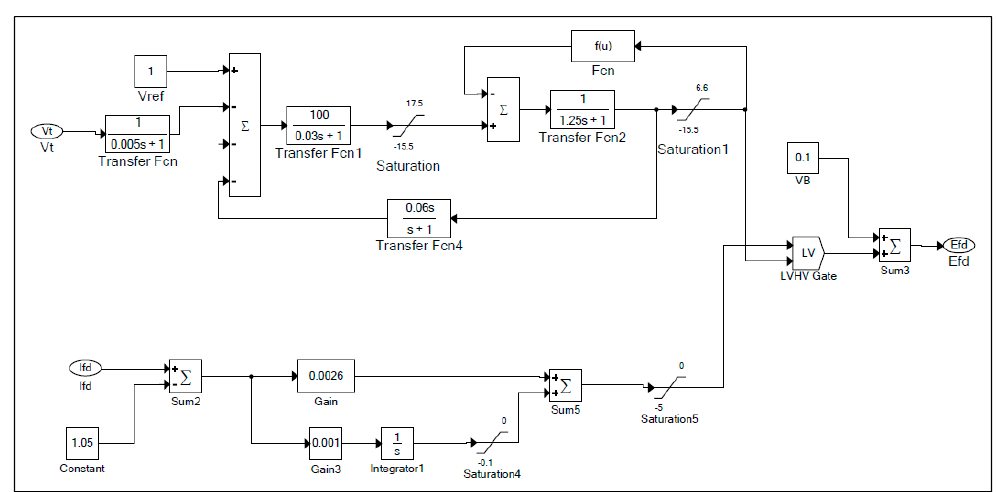
Figure 8. OEL modeling.